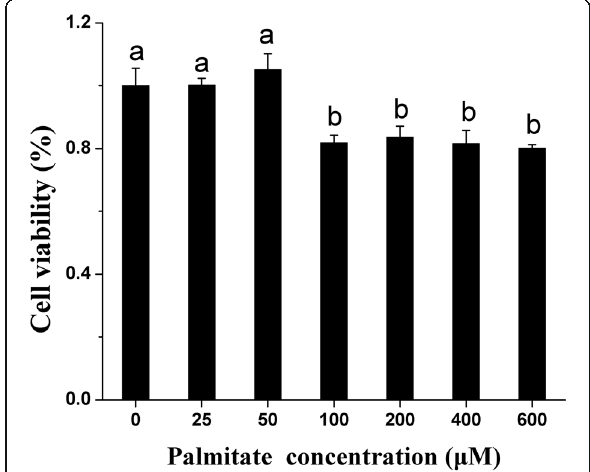
Fig. 1 Effect of palmitate on cell viability in pMECs. pMECs were incubated for 24 h with different concentrations of palmitate (0 (control), 25, 50, 100, 200, 400, and 600 μ M). Cell viability was estimated by MTT test. Values, expressed as percentage of control, are presented as mean ±SEM ( n =6). Different letters indicate statistical significance between different concentrations of palmitate treatment groups ( p <0.05)